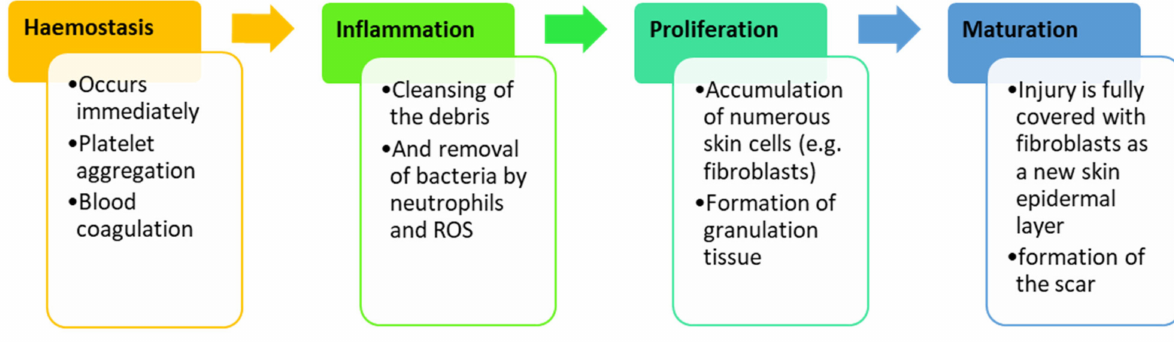
Figure 2. Sequential Phases of Wound